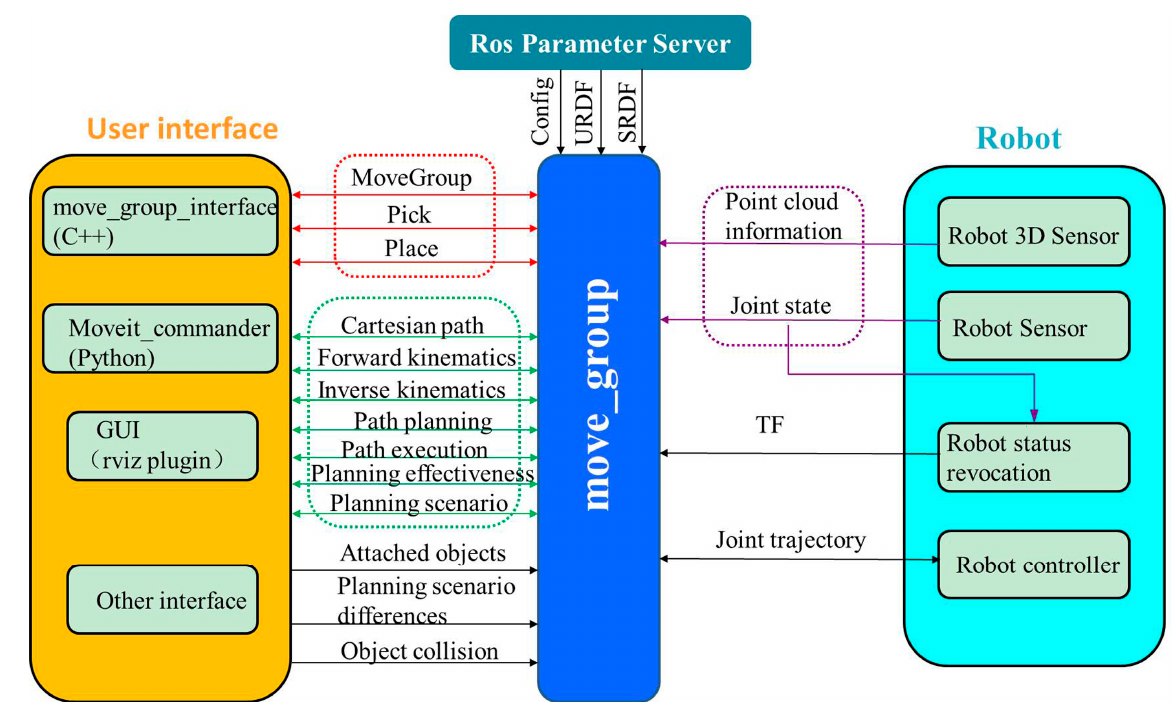
Figure 9. Structure of MoveIt! package.